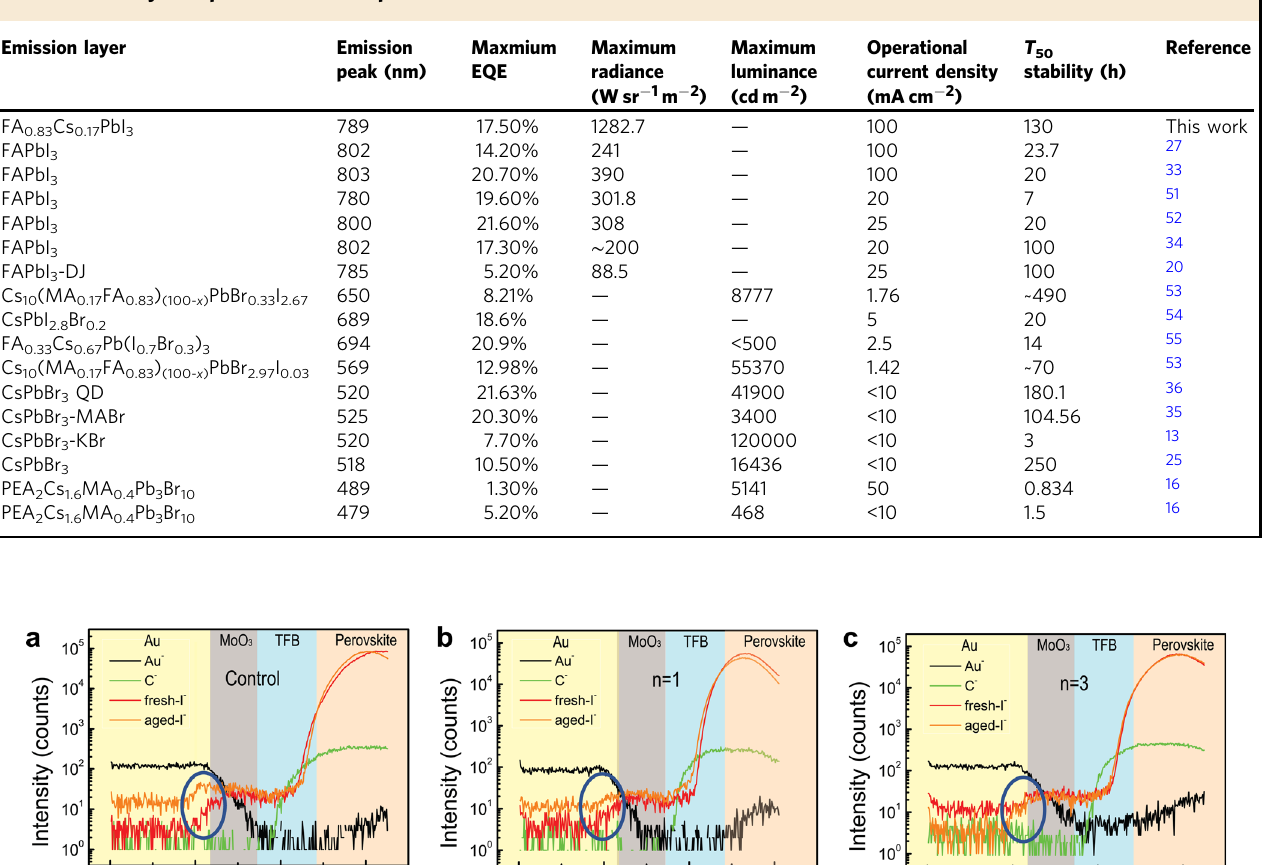
Table 1 Stability and performance comparison of PeLEDs.